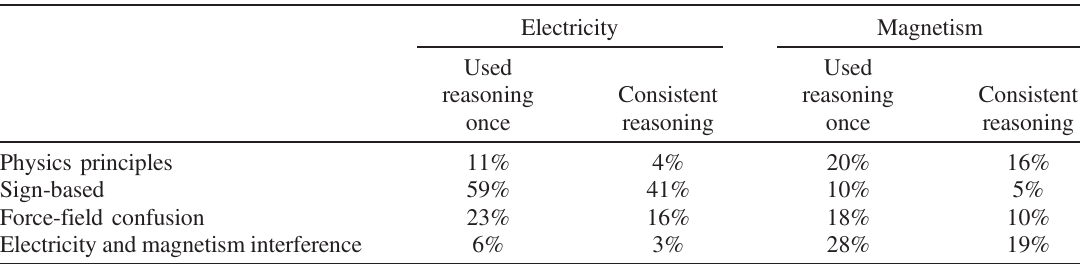
TABLE II. Consistency analysis for each pair of items in the four main result